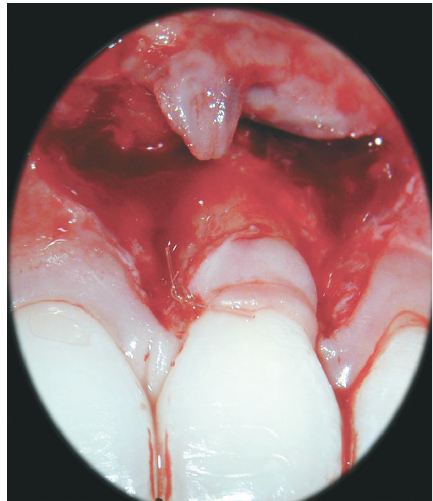
Figure 4: A connective tissue graft was placed in the site of the recession and stabilized by the use of resorbable sutures.